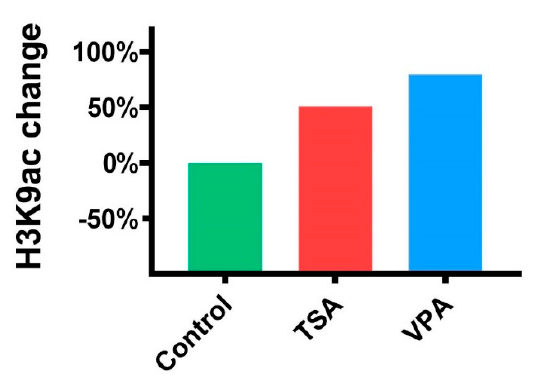
Figure 4. Acetylated histone H3K9 expression change compared to the control group.